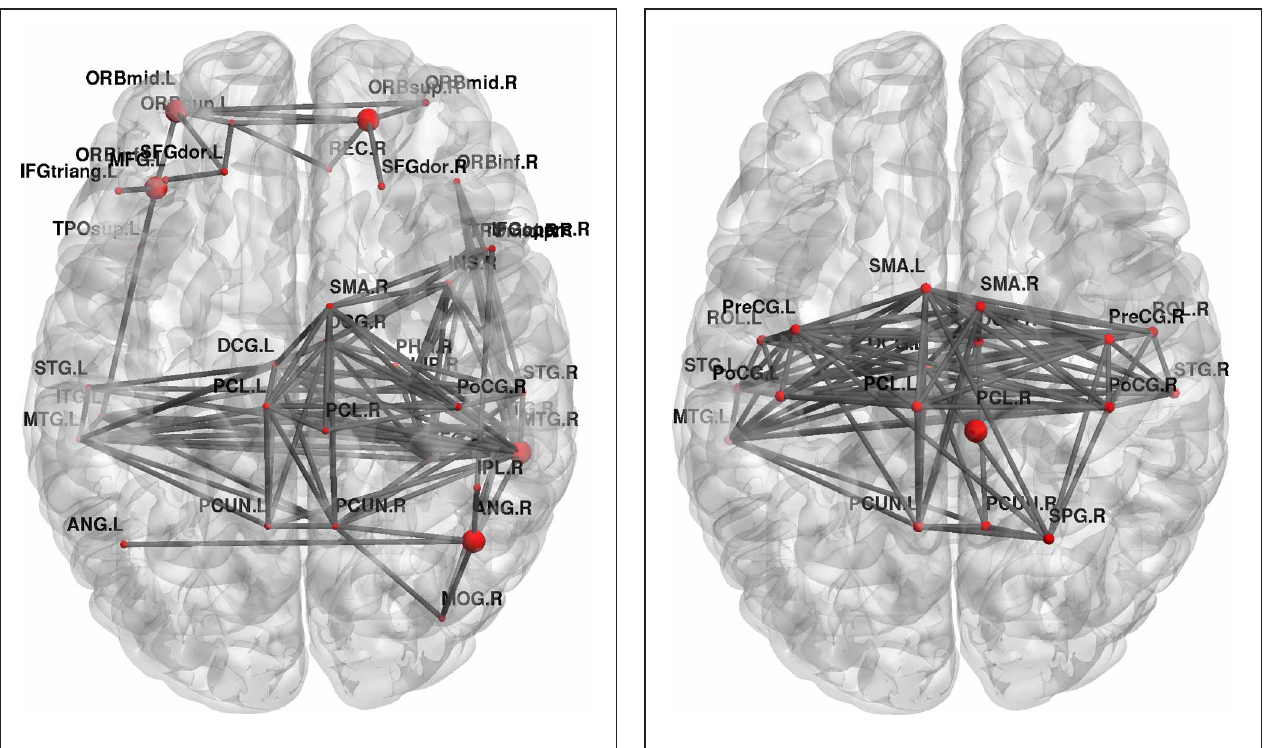
FIGURE 8 | Change in regional local efficiency following the implicit SRTT task. The format is the same as in Figure 7 . affected the outcome of the graph analysis results as all the tasks lasted ∼ 10